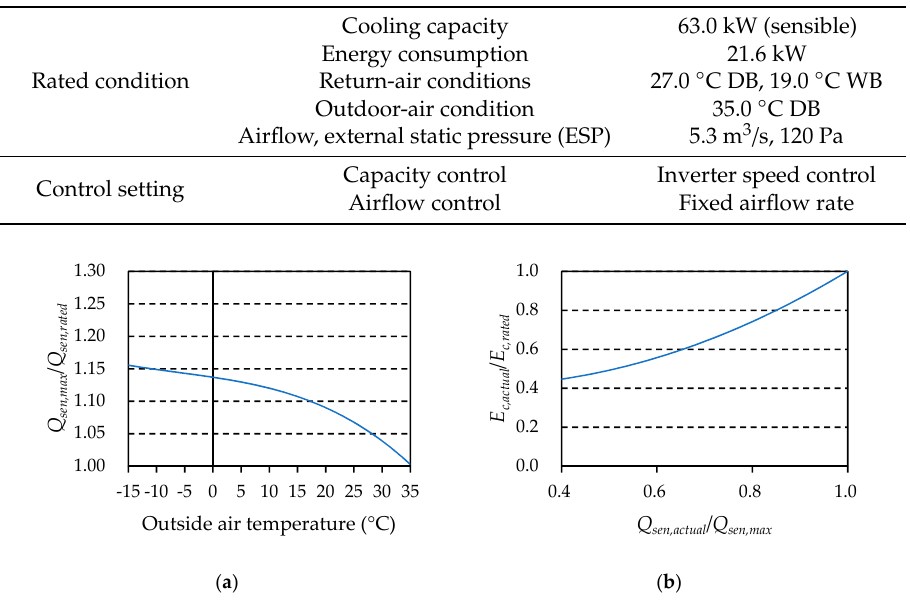
Table 9. Specifications of computer-room air-conditioning (CRAC).